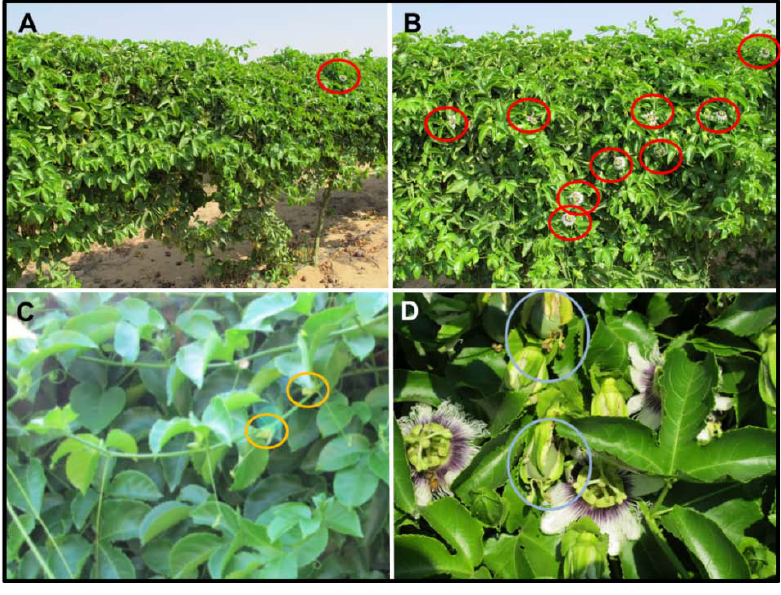
Figure 7. Pictures of PD vines in commercial orchards (2011). ( A , B ) Tzipori farm on September 22 with treatment as in Figure 6A. Most control plants ( A ) did not reach anthesis, while treated plants ( B ) are blooming. Red circles mark flowers at anthesis. ( C , D ) Moranim LTD farm on September 27 with treatment as in Figure 6B. Aborted flowers (orange circles) can be seen in control vines, while treated vines contain flowers at anthesis attracting pollinators and setting fruit (light blue